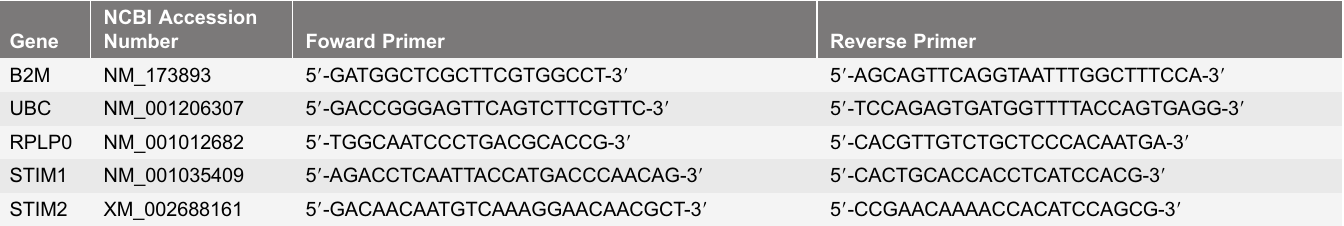
Table 1. Primers set used for the quantitative PCR